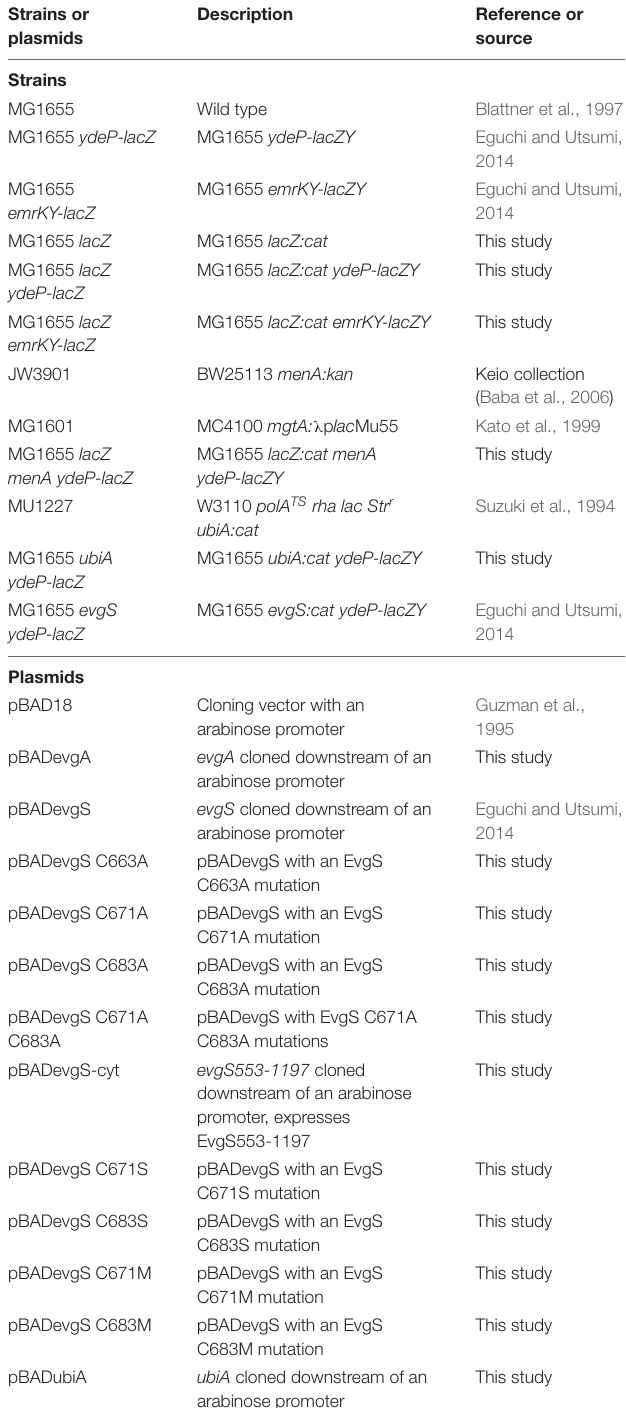
TABLE 1 | Strains and plasmids used in this